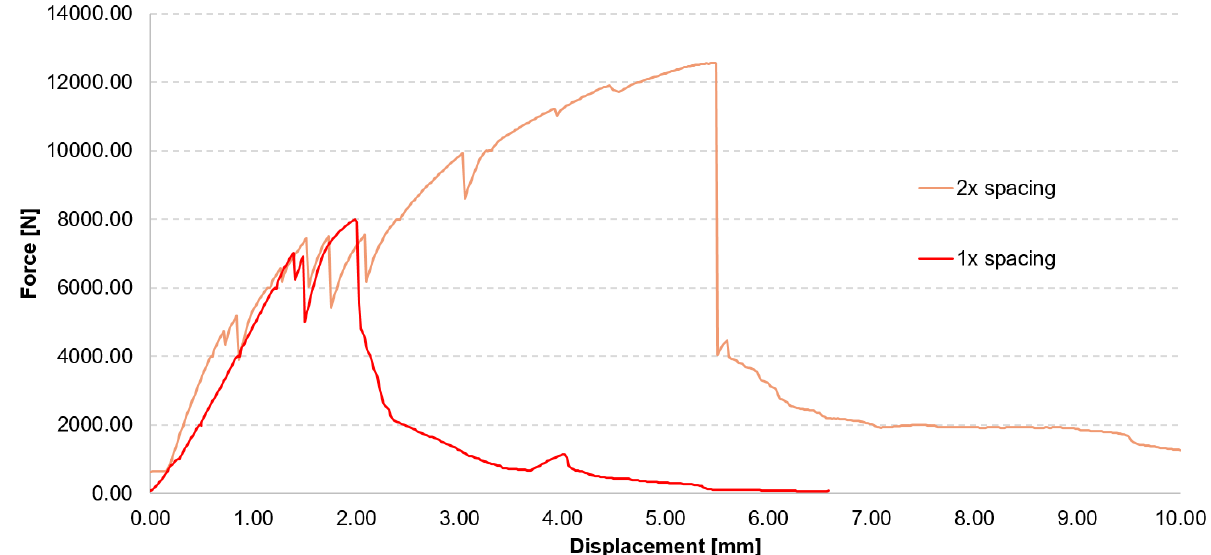
Figure 3. Test results presented in the form of force – displacement graph. One typical experimental curve for both groups is